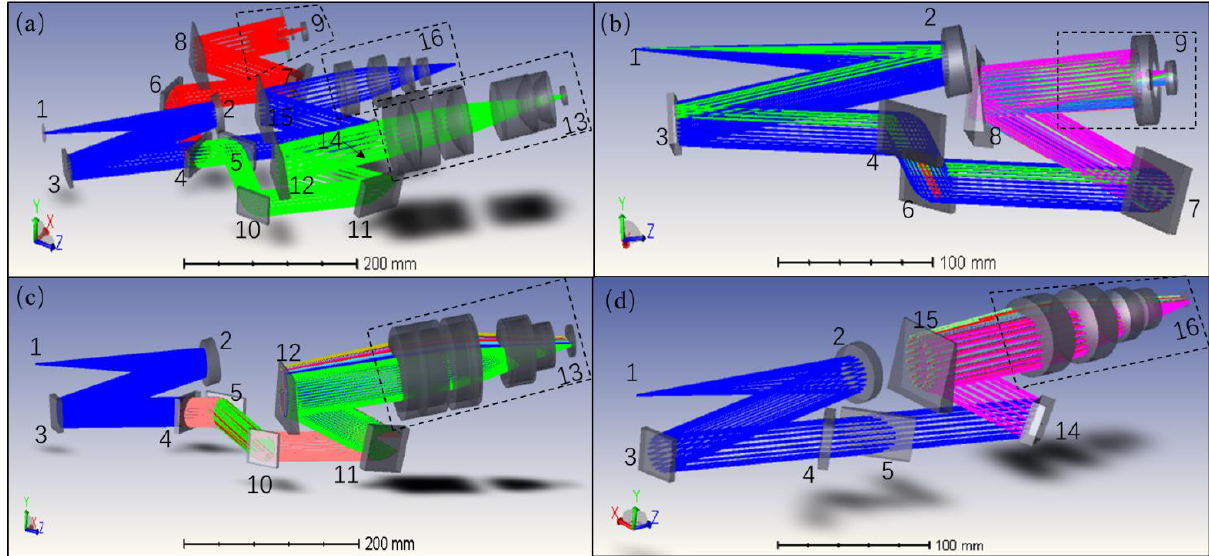
Figure 1. Optical path through the designed spectrometer. ( a ) Overall optical path of the spectrometer, ( b ) UV channel (channel 1), ( c ) visible channel (channel 2), and ( d ) NIR channel (channel 3). 1: slit; 2: off-axis parabolic collimating mirror; 3, 6, and 10: folding mirror; 4 and 5: beam splitter; 7, 11, and 14: echelle grating; 8, 12, and 15: dispersive prism; 9, 13, and 16: camera.